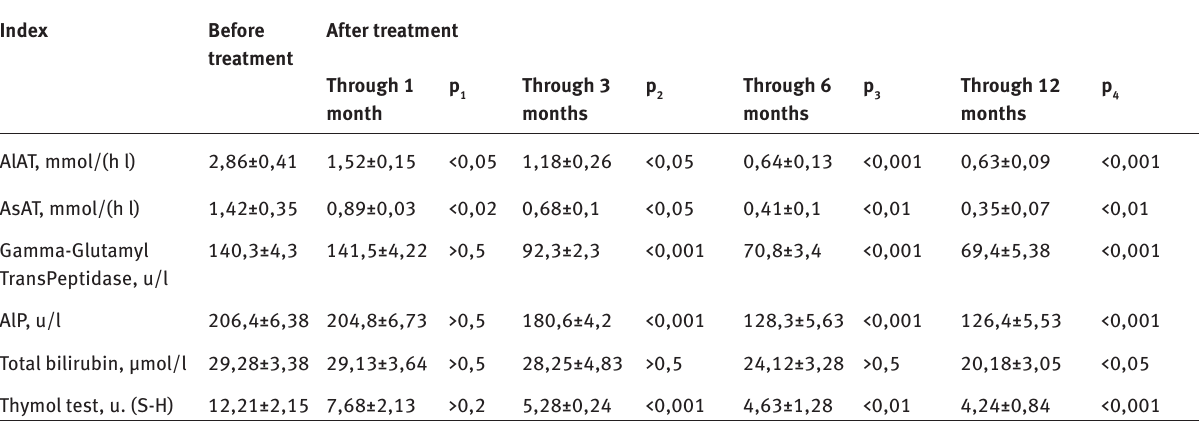
Table 1: Evolution of the functional status of the liver under influence of the standard antiviral therapy in patients with chronical viral hepati- tis C, (М±m), n = 17 (the control group).